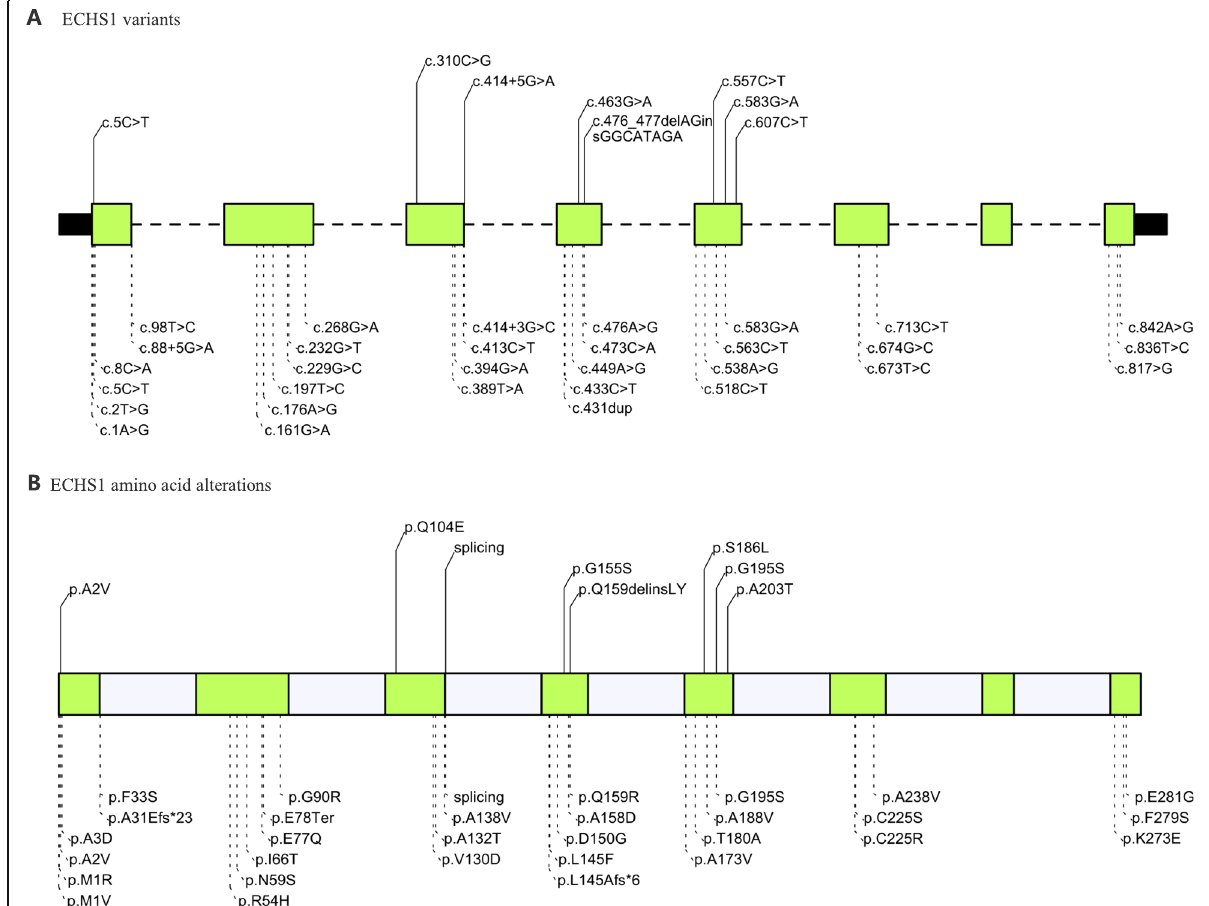
Fig. 4 Summary of the variants and amino acid alterations of ECHS1 gene related to Leigh syndrome. (A) The previously reported variants (below the bar with dashed lines) and the newly identified variants (above the bar with solid lines); (B) The previously reported amino acid alterations (below the bar with dashed lines) and the newly identified amino acid alterations (above the bar with solid